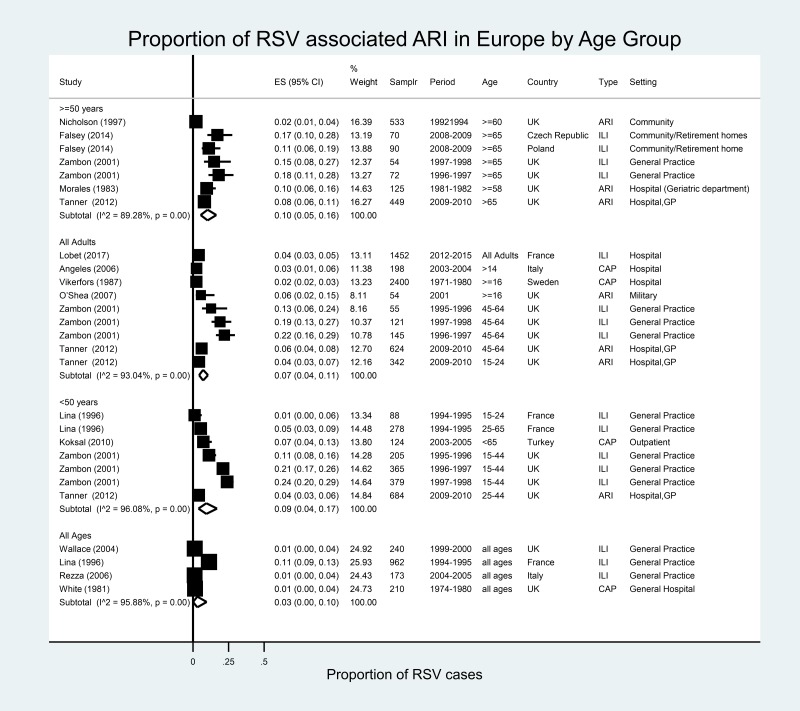
Proportion of RSV among ARI/ILI in adults in Europe.